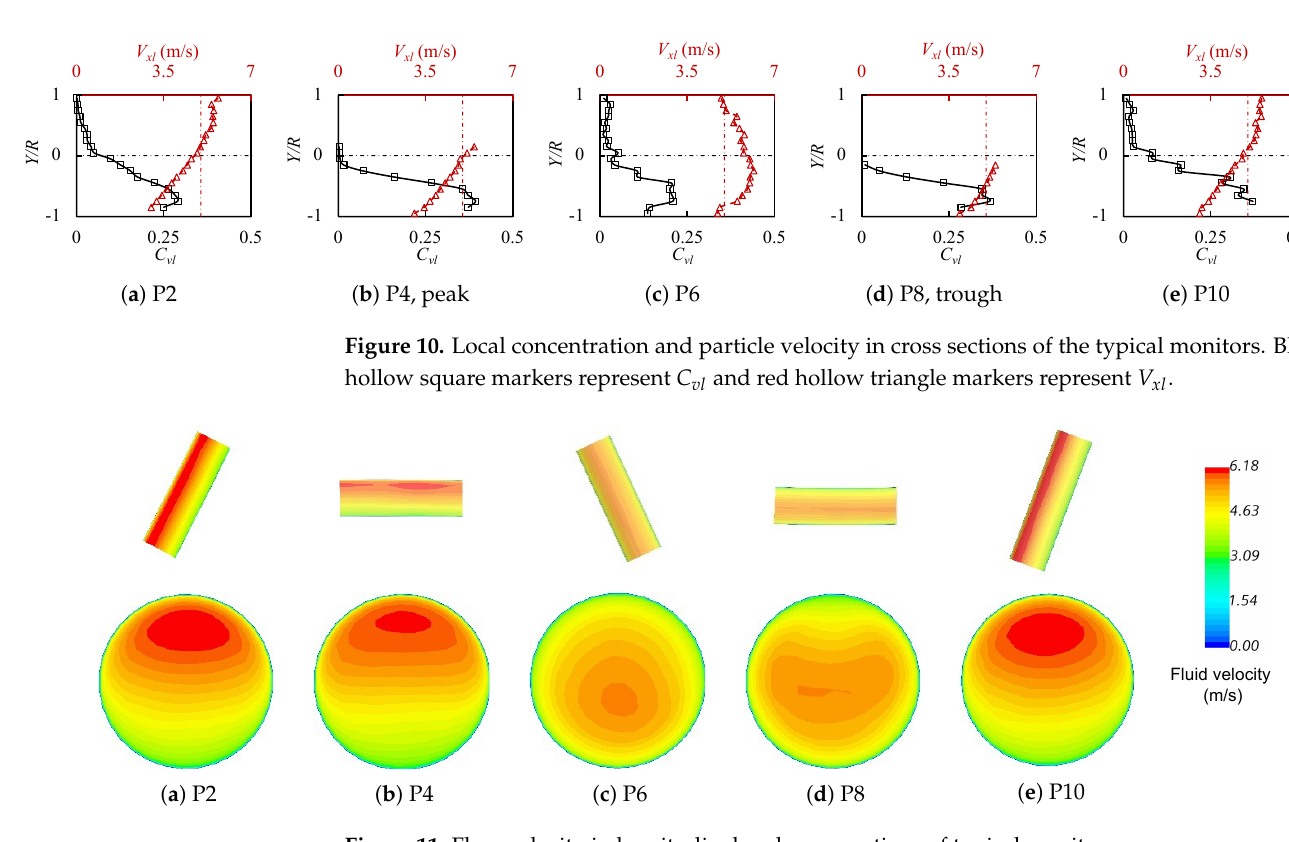
Figure 11. Flow velocity in longitudinal and cross sections of typical